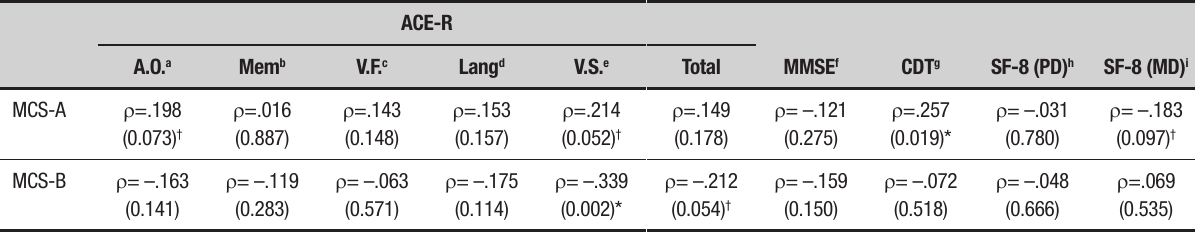
Table 5. Correlation between MCS-A / MCS-B, cognitive performance, and self-perceived